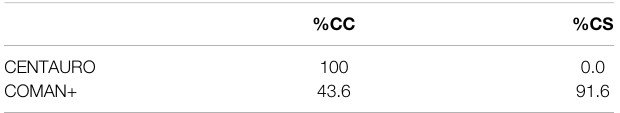
TABLE 2 | Percentages of fail of the centroidal statics check (%CS) and of the collision check (%CC) relative to the total number of fails in the corridor scenario for both CENTAURO and COMAN+.